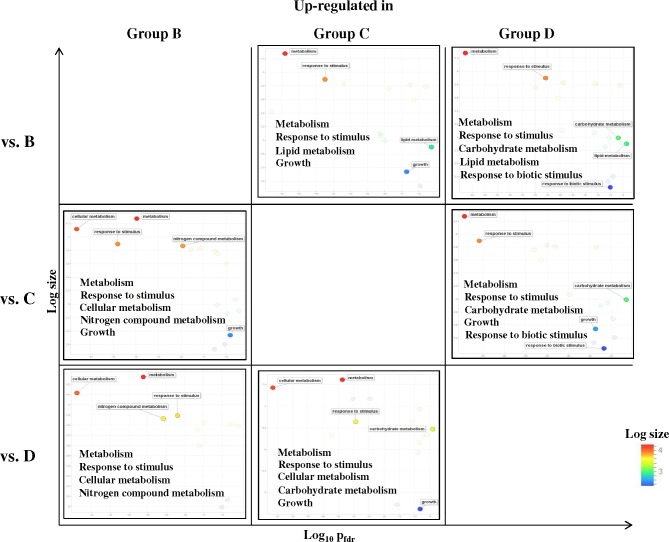
Gene ontology enrichment of significantly up-regulated transcripts between the commercial groups (B-D).Significantly up-regulated transcripts of were analyzed by singular enrichment analysis (agriGO). Results of individual comparisons were presented in a three by three plot. Out of the many ‘Biological Processes’ found to be significantly enriched, those related to metabolism and growth were highlighted and compared upon.